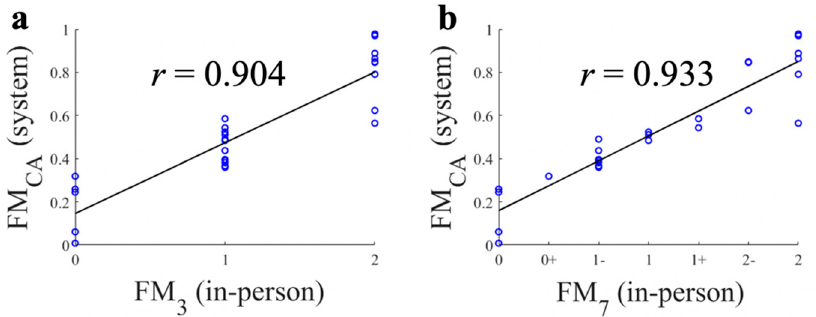
Figure 4. Correlations between continuous FM scale (FM CA ), three point FM scale (FM 3 ), and seven point FM scale (FM 7 ). ( a ) FM CA and FM 3 ; ( b ) FM CA and FM 7 .